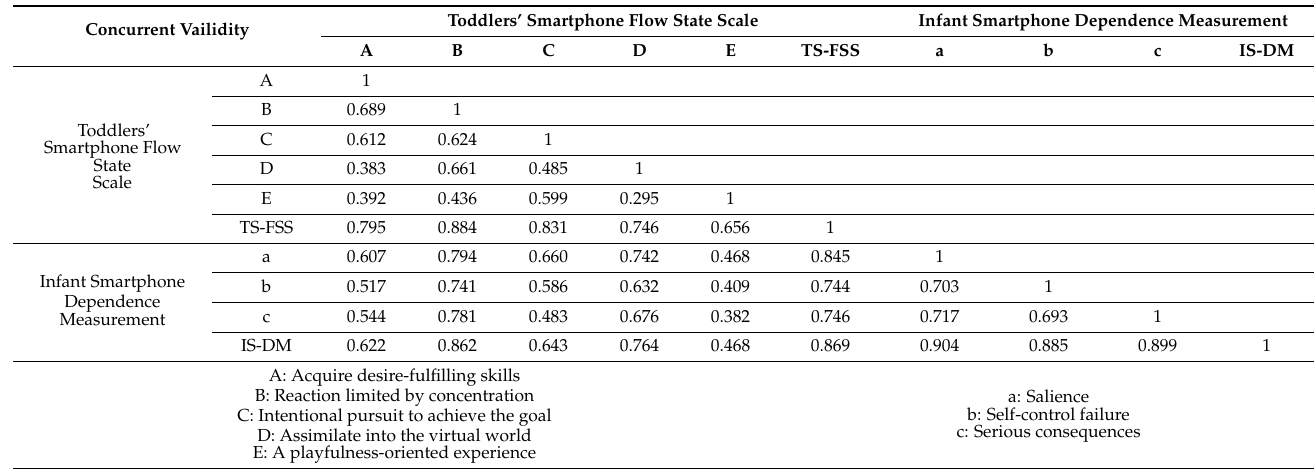
Table 7. Concurrent validity for TS-FSS ( n = 72).